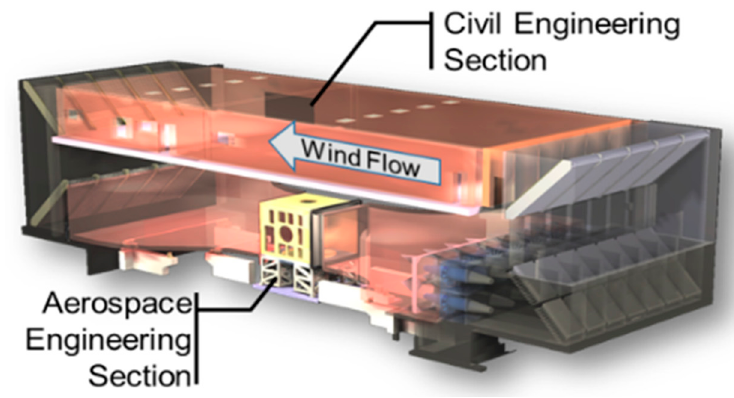
Figure 1. Configuration of the wind tunnel.